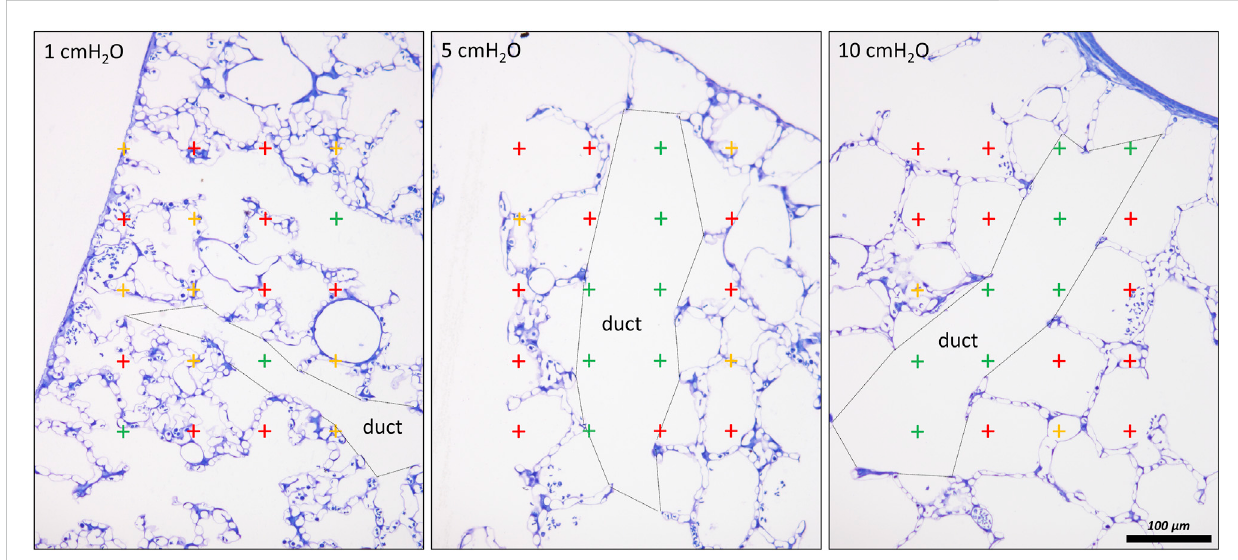
FIGURE 7 Differentiation of acinar airspaces by point counting: Healthy rat lungs were fi xed in vivo by vascular perfusion via the vena cava caudalis at airway openingpressuresofeither1,5,and10cmH 2 Oonexpirationaftertworecruitmentmaneuvers(3 spauseat30 cmH 2 O)(Knudsenetal.,2018).Inorderto determine thevolume fractions oftissue,alveolaroralveolarductairspaceswithin thelung,testpointsweresuperimposed onrandomized fi eldsofview. Lungs weretreatedbyimmersionin4%OsO 4 beforedehydration andembeddedinglycol methacrylatetoavoid shrinkage/tissuedeformationafter fi xation.Theprobabilityofatestpointhittingthepro fi leofastructureofinterestisdirectly proportional tothevolume fractionofthisstructureofinterest withinthereferencespace.Theratiooftestpointshittingthestructureofinterestandthereferencespaceprovidesthevolumefractionofthestructureof interest. In the examples, the probability of a test point placed on the randomly sampled fi elds of view depends on the volume fraction of tissue, alveolar airspace or alveolar duct airspace within the lung. The multiplication of the volume fractions with the lung volume will result in the absolute volumes of tissue,alveolarairspaceoralveolarductairspaceperlung.Withthegoaltoseparatealveolarductandalveolarairspace,theentrancesintothealveoliwere closed by drawing a straight line between the edges of the interalveolar septa. Points hitting alveolar duct airspace (green), alveolar airspace (red) and tissue(yellow)werelabelledintheexamples.AtlowPao,thealveolarductsweresmallandtheinter-alveolarseptaappearedtobeatrestwithacurvyorin part crumpled surface. At larger Pao, the alveolar ducts widened considerably, the inter-alveolar septa straightened (and appeared to be under tension) and the alveoli became larger. The number of test points hitting alveolar as well as alveolar duct airspaces increased on the expense of the tissue. If the images were representative for the whole organ, one would assume that the volume fractions of tissue deceases with in fl ation pressure. In order to be representative, however, it is advised to count 100 — 200 hits on a structure of interest from at least 60 randomized fi elds of view sampled from at least four randomized sections per